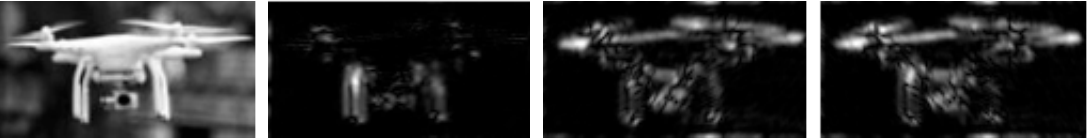
Figure 3. Log-Gabor filter amplitude with three orientations of unmanned aerial vehicle (UAV) image.